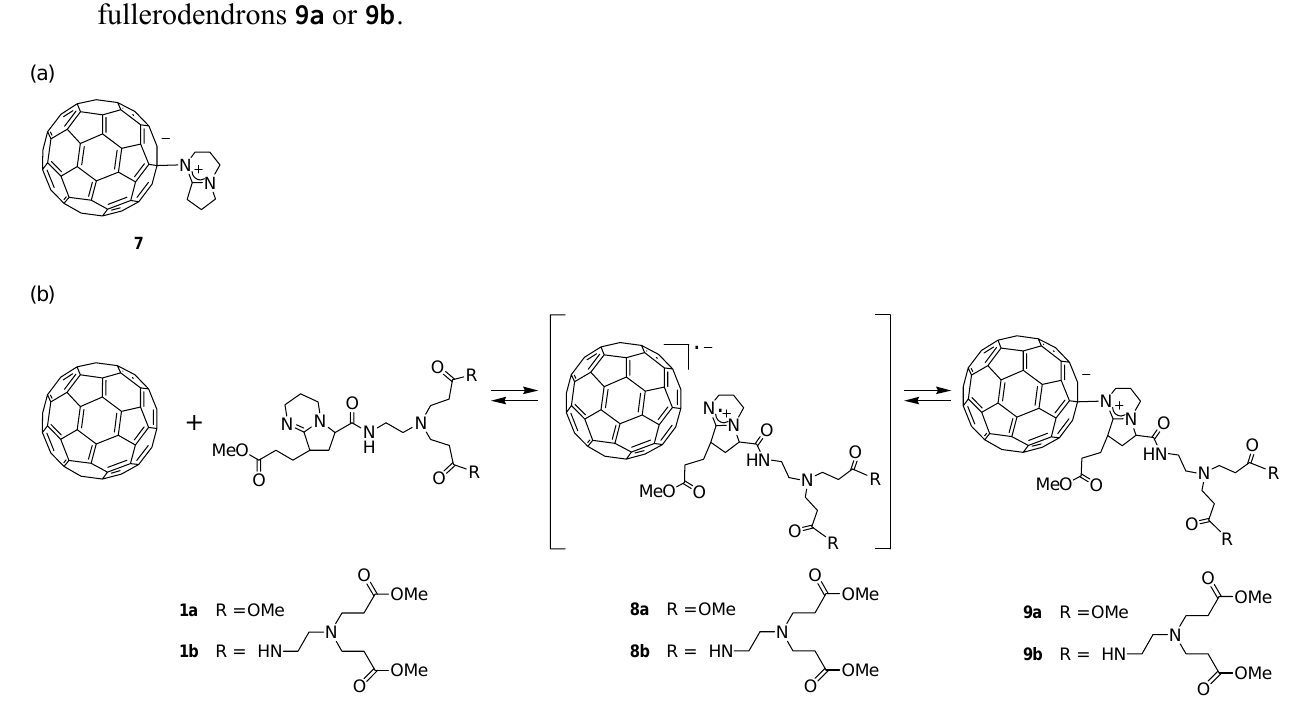
Scheme 2. (a) Structure of zwitterionic complex 7 . (b) Formation of zwitterionic fullerodendrons 9a or 9b .